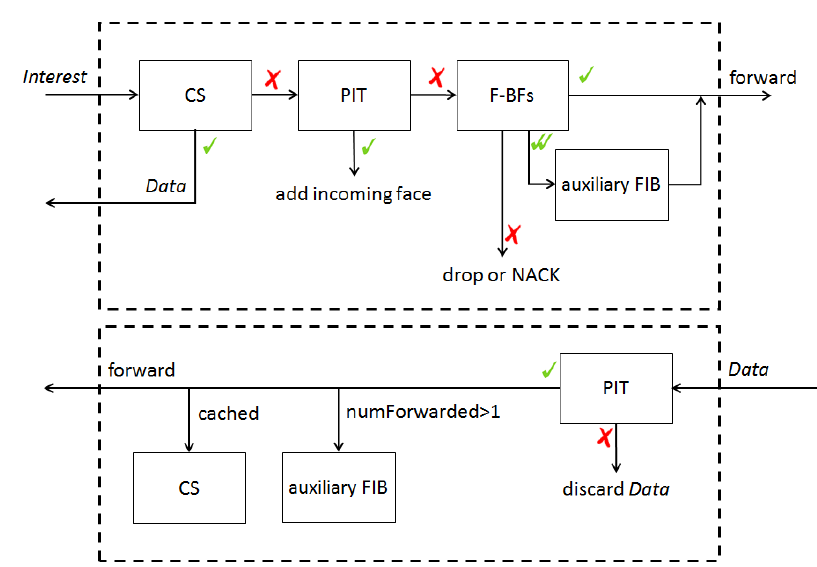
Figure 5. Packet handling procedure [5], where the upper part illustrates the Interest packet handling procedure and the lower part describes the Data packet handling procedure. Algorithm 3: Procedure for forwarding Interest packets. Function OnInterest